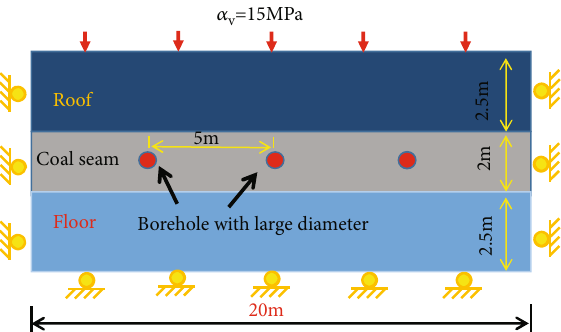
Figure 2: Geometric model of numerical simulation.